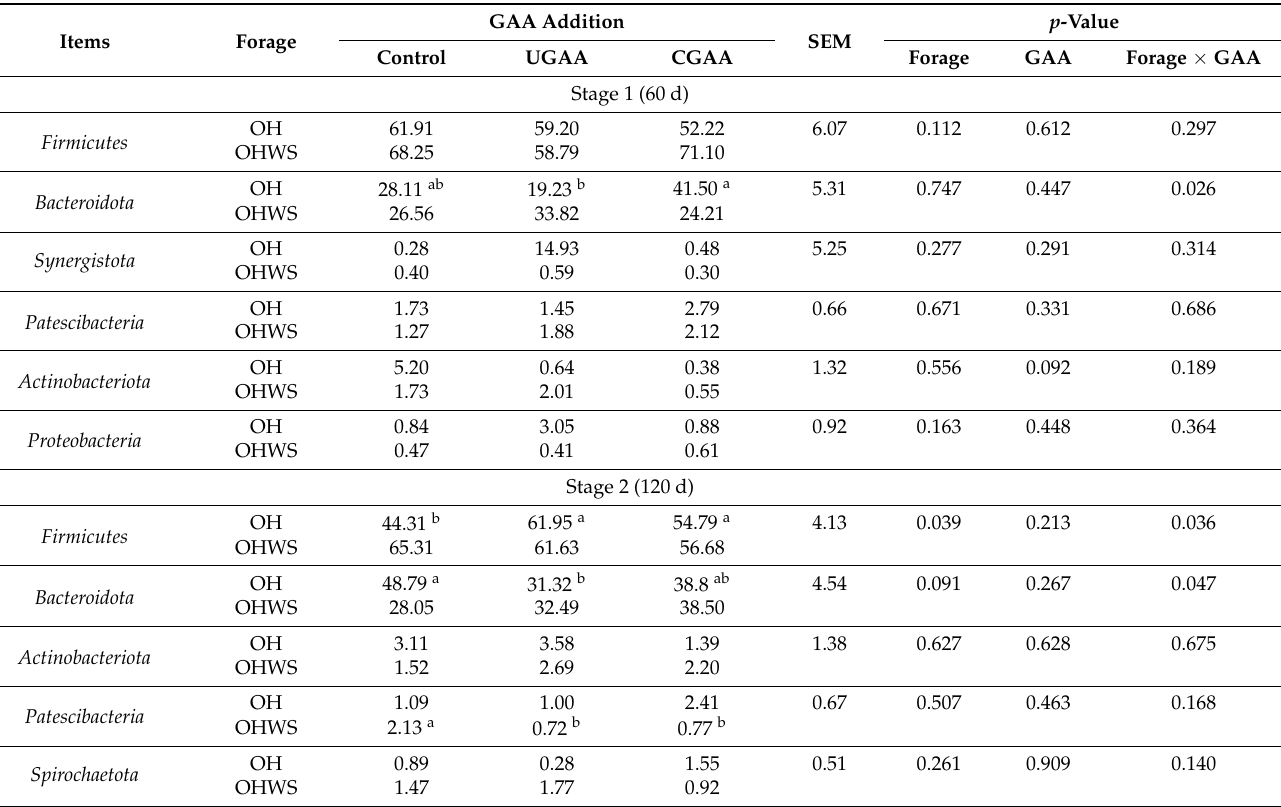
Table 3. Microbial community analysis at the phylum level (relative abundance > 1%) of microbiomes obtained from rumen fluids of lambs at different feeding